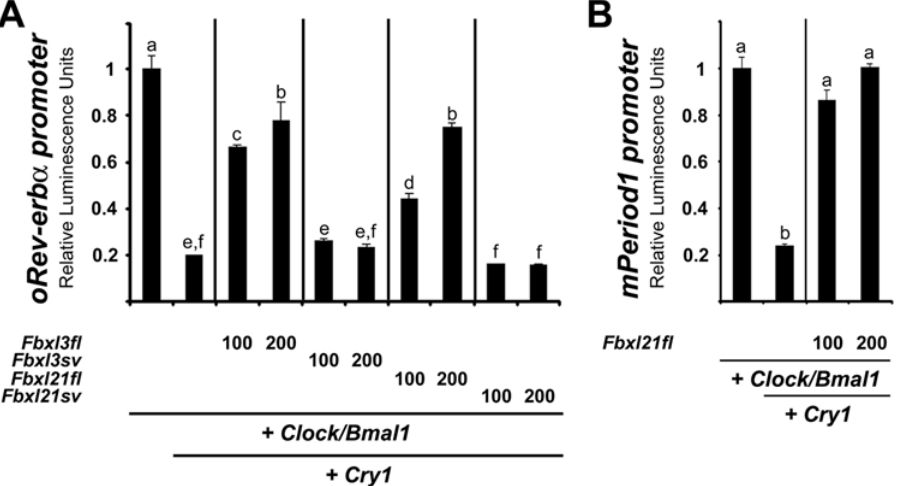
Figure 4. Functional transcriptional effects of Fbxl3 and Fbxl21. A . oFbxl3 and oFbxl21 dose-dependently reverse oCRY1 inhibition of oCLK/ oBM1 induced transactivation of an oRev-erb a reporter construct. Transfection conditions per well: 100 ng of oClock, 100 ng of oBmal1, 100 ng of oCry1, 100 or 200 ng of each Fbxl or ev, 50 ng of oRev-erb alpha promoter reporter, 50 ng of b-Gal reporter and/or necessary amount of empty vector to make a final amount of 600 ng. B . mFbxl21 dose-dependently reverses mCRY1 inhibition of mCLK/mBM1 induced transactivation of an mPer1 reporter construct. Transfection conditions per well: 100 ng of mClock, 100 ng of mBmal1, 20 ng of oCry1, 100 or 200 ng of mFbxl21 or ev, 50 ng of Per1 promoter reporter, 50 ng of b-Gal reporter and/or necessary amount of empty vector to make a final amount of 600 ng. Data in A/B are mean 6 SEM of one triplicate representative from 3 replicate experiments. Different letters above bars indicate significantly different groups (p , 0.05).